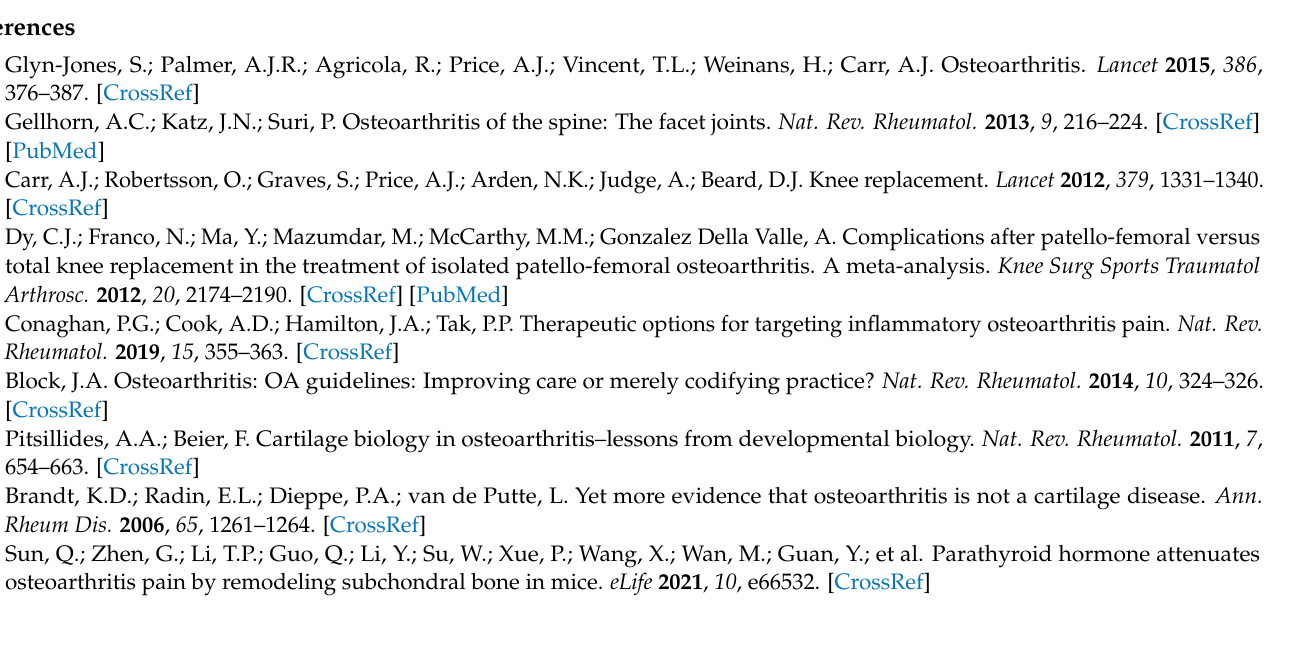
Figure S6: COX-2 exhibits increase expression in the DMM subchondral bone; Table S1: Mouse